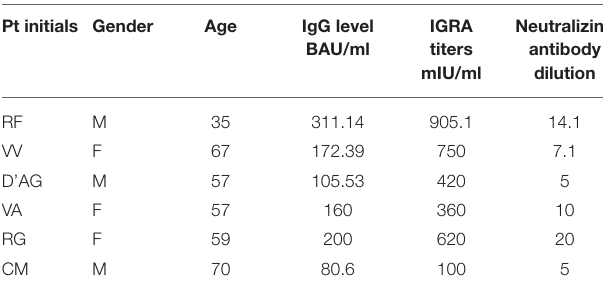
TABLE 3 | Characteristics of patients with breakthrough